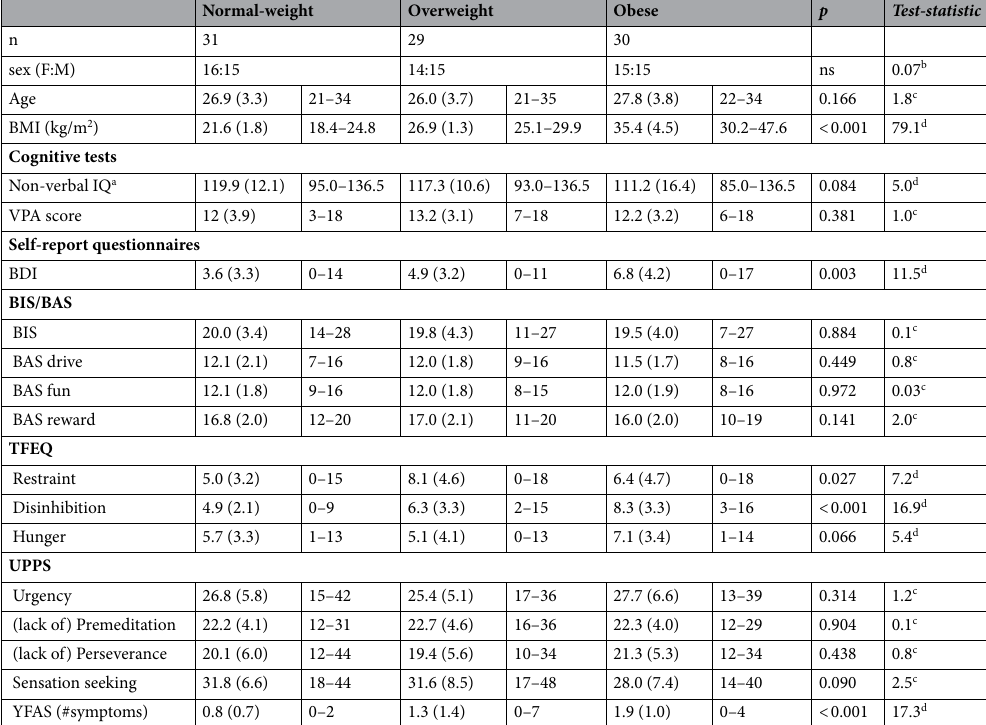
Table 1. Group characteristics displaying mean (standard deviation) and range if not otherwise stated, followed by the test-statistic and p-value of group comparison for each measure. N number of participants; F:M the ratio of females to males; VPA visual paired associates test of the Wechsler Memory Scale; BDI Beck’s Depression Inventory; BIS/BAS Behavioural Inhibition System/Behavioural Activation System; TFEQ Three-Factor Eating Questionnaire; UPPS Urgency, lack of Premeditation, lack of Perseverance, and Sensation seeking; YFAS Yale Food Addiction Scale. a Non-verbal IQ was calculated based on the Viennese Matrices Test (VMT). b Chi square test for frequency data (degrees of freedom: 2). c F-test with for normally distributed scores (degrees of freedom: 2.87). d Independent-Samples Kruskal–Wallis Test of distributions for non-normally distributed scores (degrees of freedom: